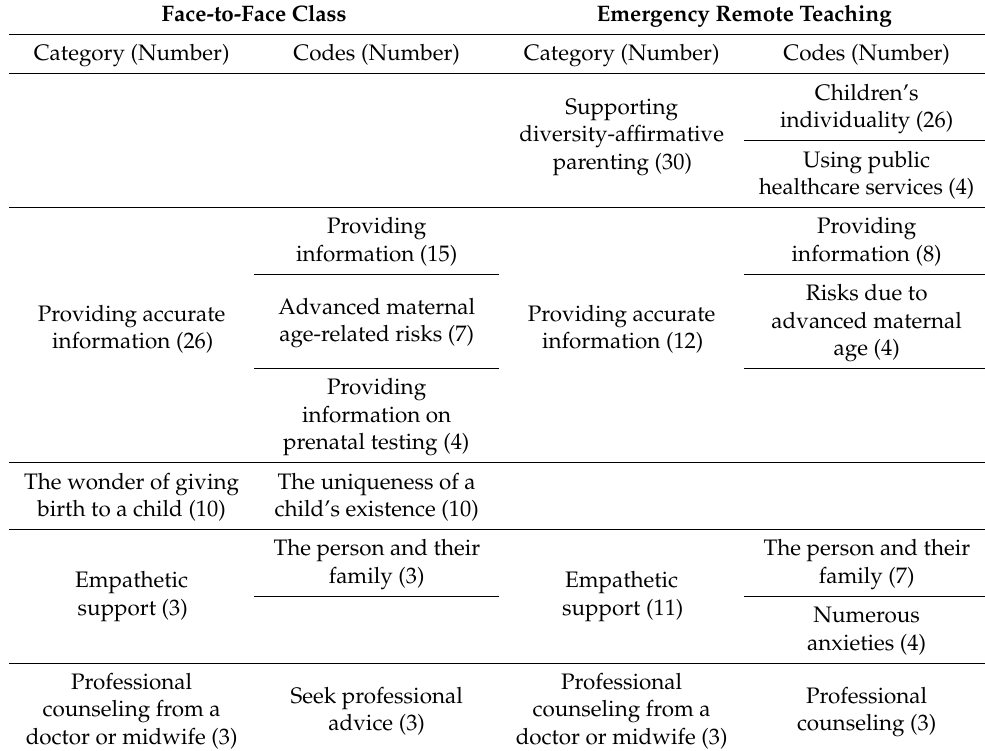
Table 4. Categories extracted from